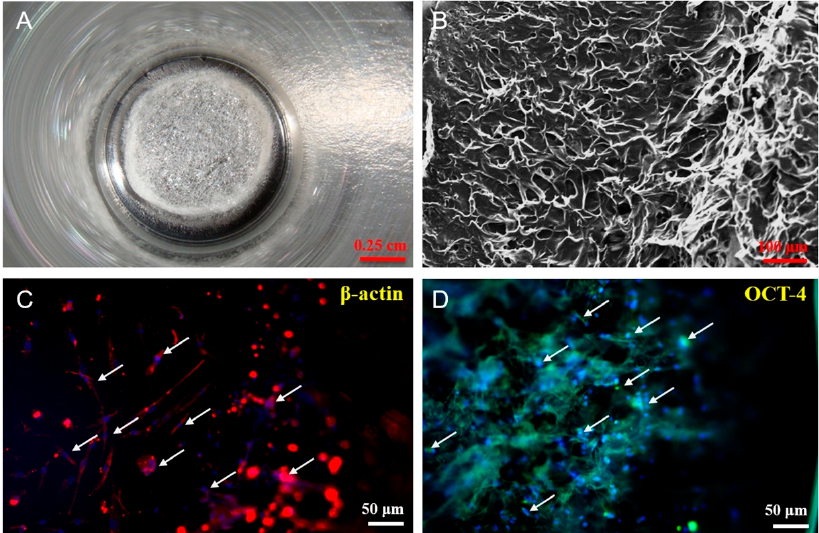
Figure 3. Characterization of the collagen scaffold. ( A ) Macroscopic appearance of collagen scaffold; ( B ) morphology of collagen scaffold characterized by SEM; ( C , D ) in vitro biocompatibility of collagen sca ff old characterized by immunofluorescence staining of hASCs with beta-actin ( β -actin) and octamer-binding protein 4 (OCT-4) counterstained with Hoechst 33342, respectively. (white arrow = cell nuclei stained by Hoechst